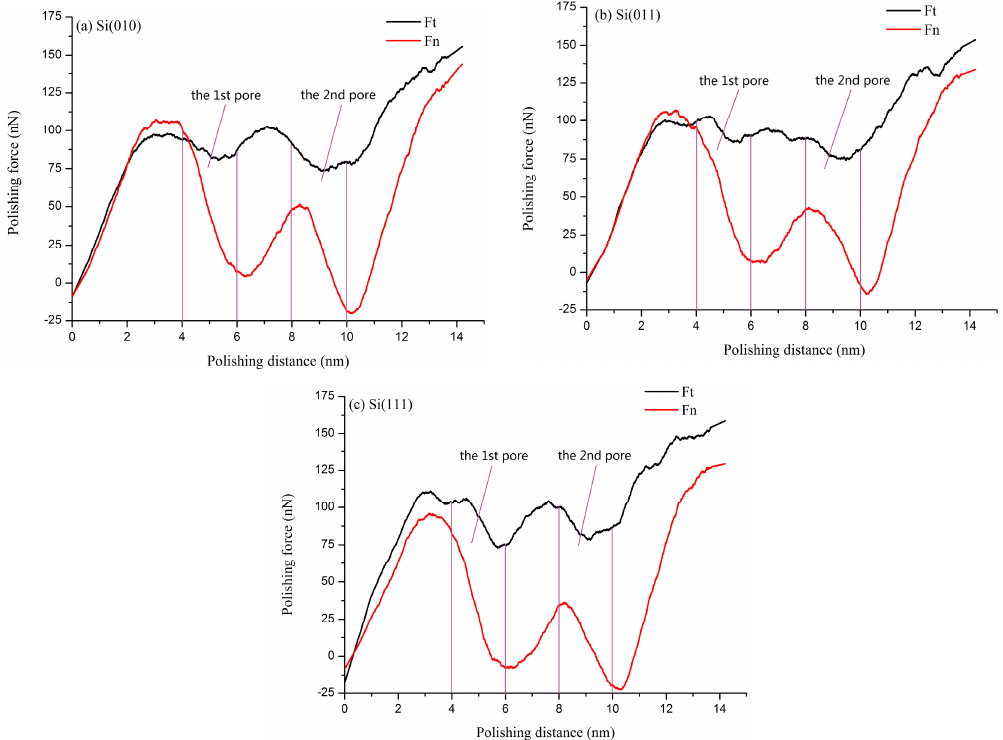
Figure 8. Effects of anisotropy on the polishing force at the polishing depth of 1.0